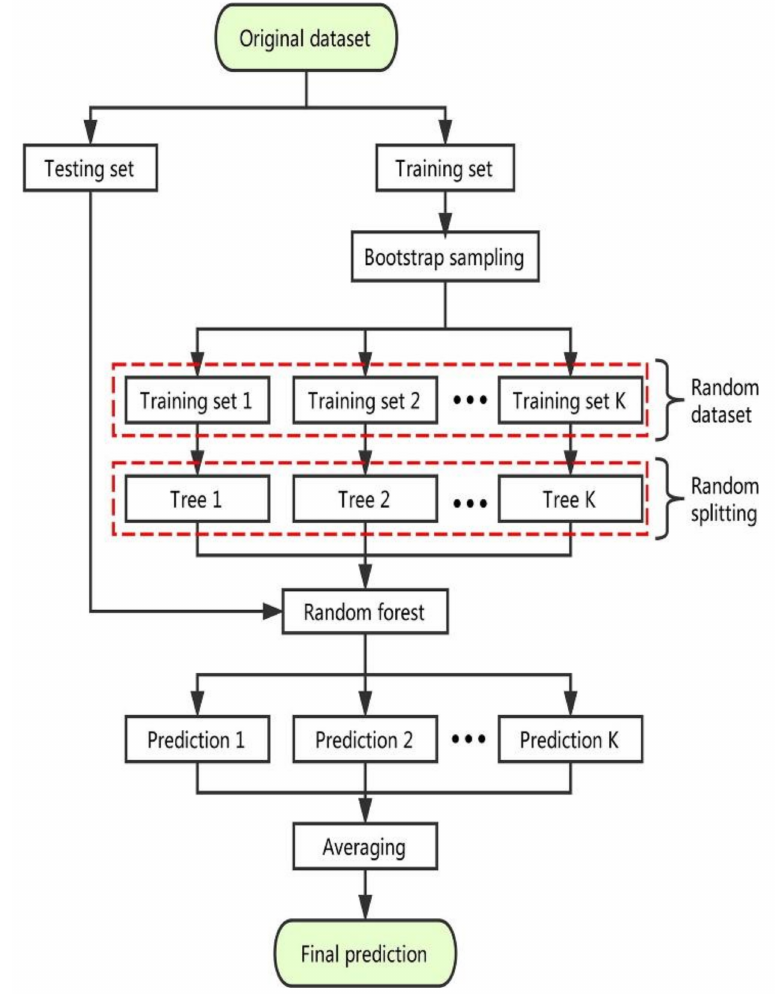
Figure 6. Predictive process of the RF model